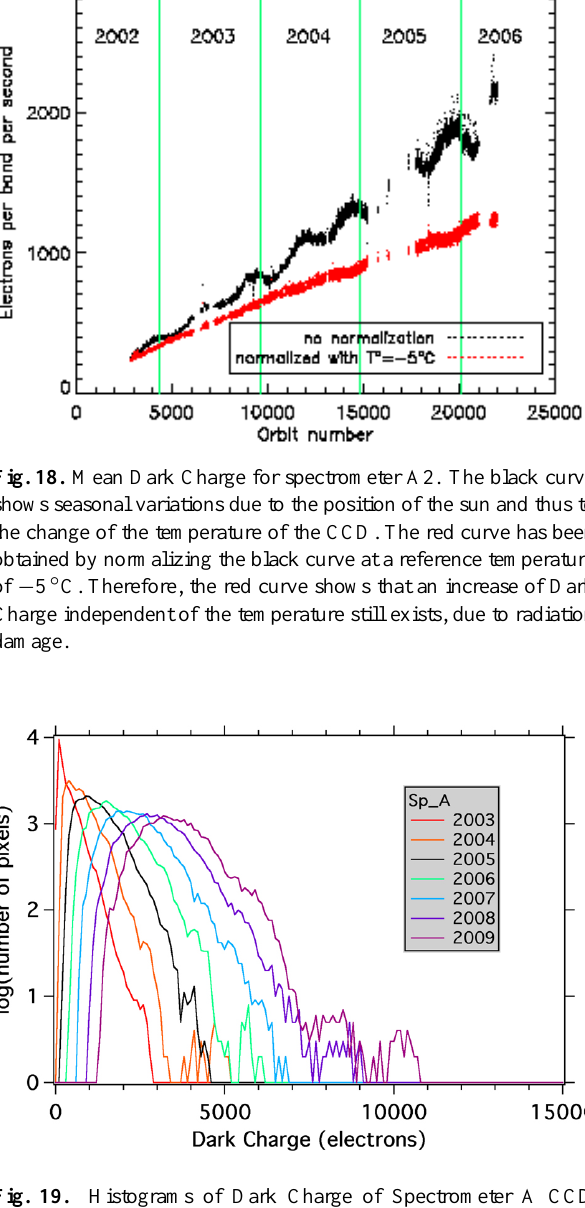
Fig. 19. Histograms of Dark Charge of Spectrometer A CCD detectors. The bins are 100electrons; the vertical scale is the Log 10 of the number of pixels having the specific dark charge of the bin. They are collected around the 1st of January, during 20 Dark Sky Area observations dedicated to the measurement of Dark Charge. The Dark Charge is increasing from year to year, due to accumulated radiation